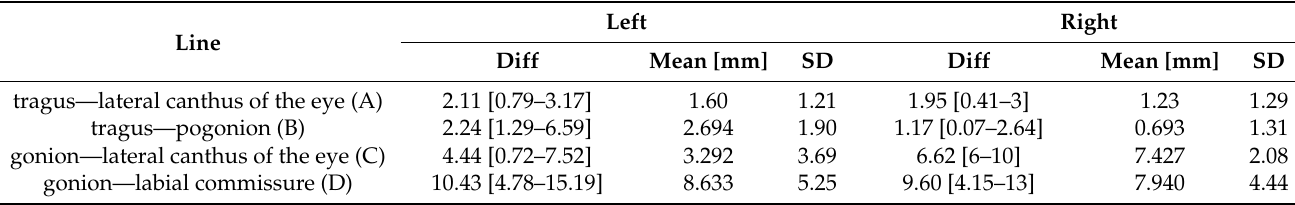
Table 3. Difference in distances from ground